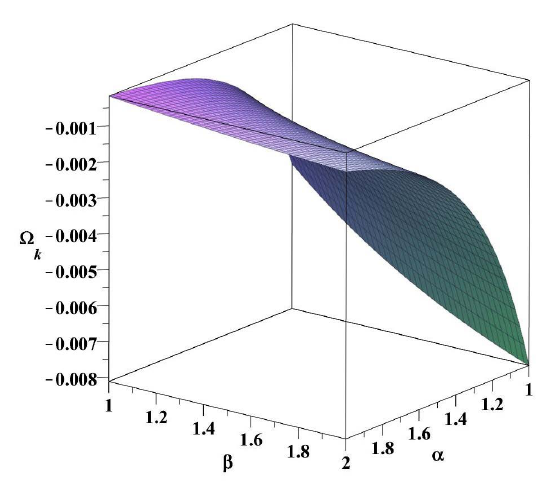
Figure 1. The plot of Ω 0, k = 1 for n = 500000 and | Γ | =